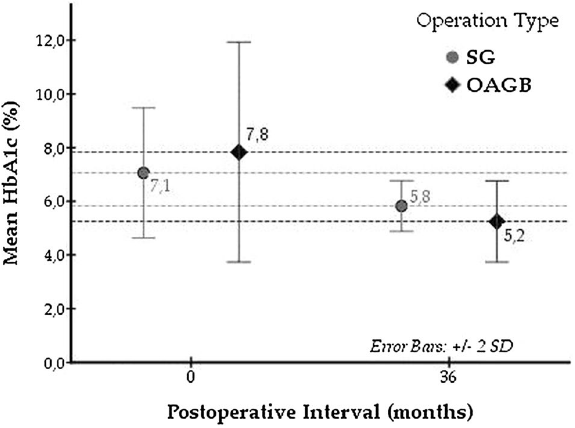
Figure 1. Mean absolute values, as well as the produced differences, of HbA1c (%) levels in the SG and OAGB groups at the time of the operation and 36 months